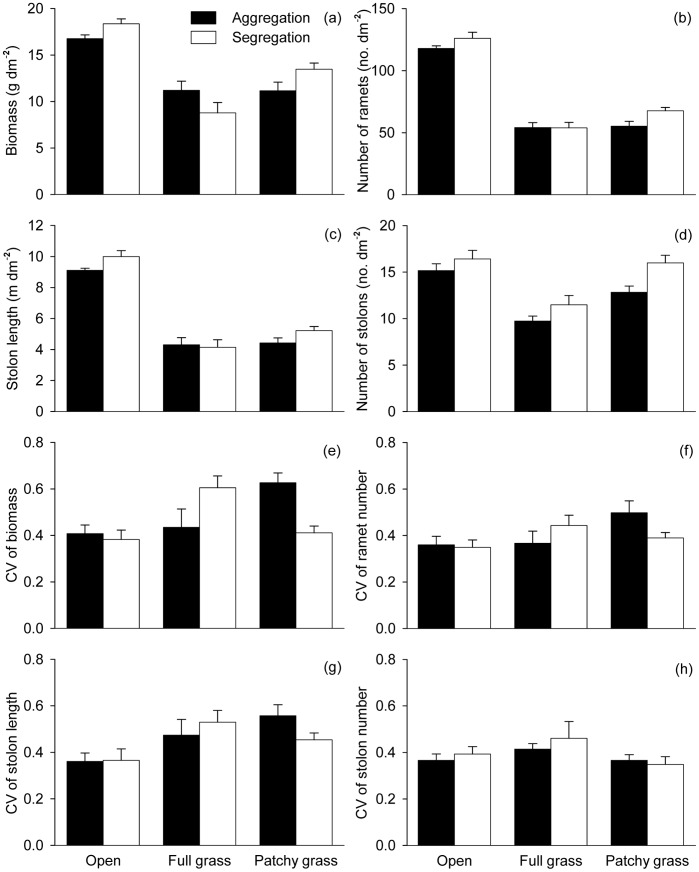
Effects of neighbor interference (open vs. full grass vs. patchy grass) and ramet aggregation (aggregation vs. segregation) on the growth (a–d) and size inequality (e–h) of the Hydrocotyle vulgaris populations.Error bars show +1 SE.